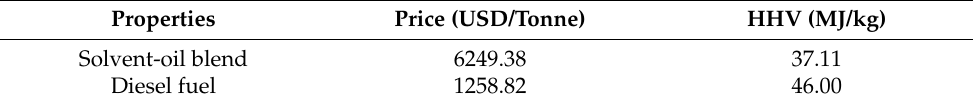
Table 8. Price and HHV for both solvent-oil blend and diesel